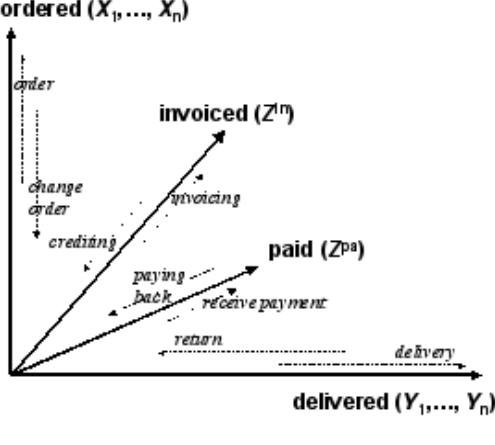
Figure 4. State space dimensions as